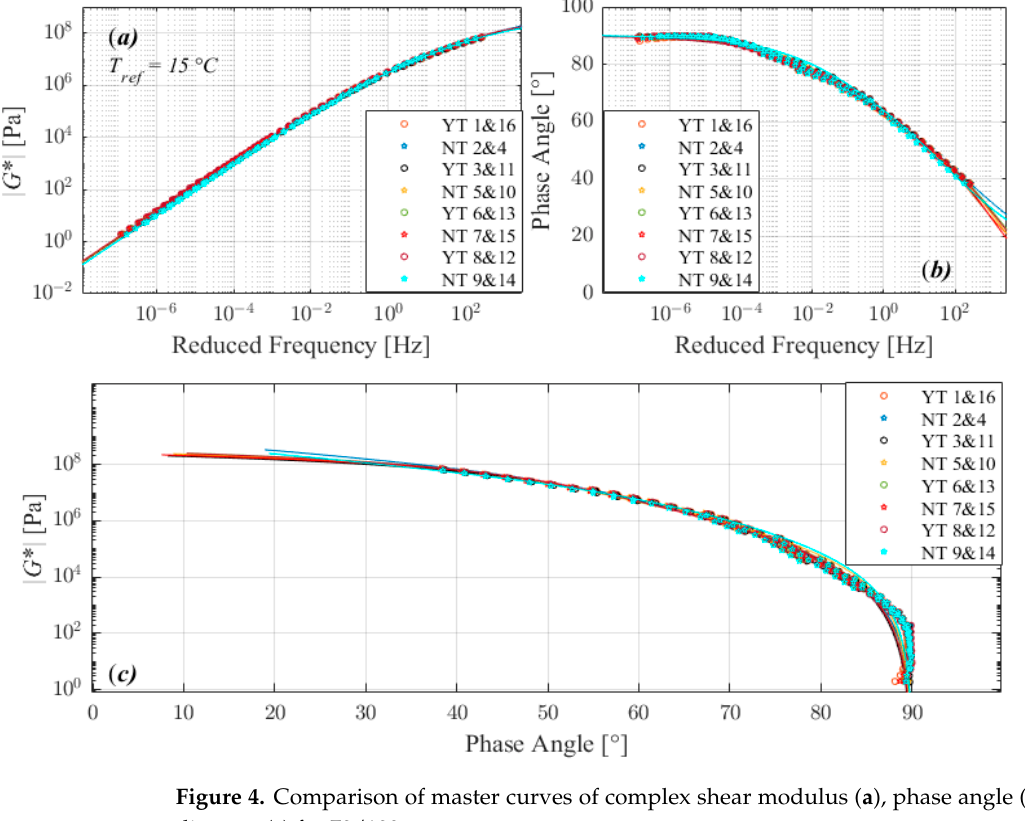
Figure 4. Comparison of master curves of complex shear modulus ( a ), phase angle ( b ), and black diagram ( c ) for 70/100.